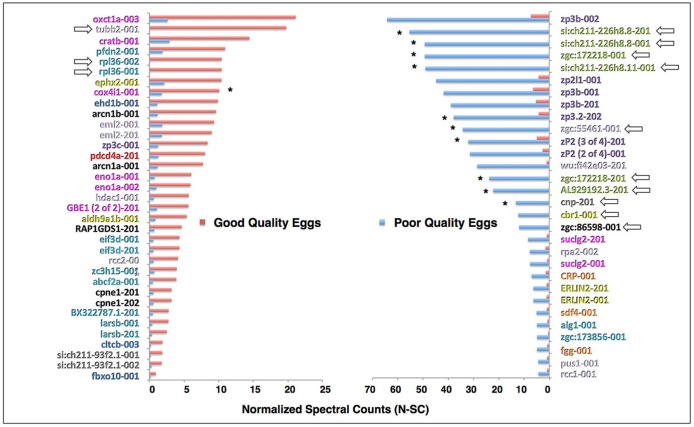
Proteins highly up-regulated in good or poor quality eggs in the Pooled Samples Experiment.The proteins are named for the transcript(s) to which spectra were mapped; for full protein names see S1 Table. These proteins were either unique to an egg quality type or they showed a ≥5-fold difference in N-SC between egg quality types, placing them in the top 2.3% of proteins showing such differences. Left Panel. Proteins highly up-regulated in good quality eggs. Right Panel. Proteins highly up-regulated in poor quality eggs. Where possible, protein (transcript) labels are color-coded to indicate functional categories to which the proteins were attributed (Fig 2). Arrows indicate proteins unique to an egg quality type. Asterisks indicate proteins detected and regulated in the same direction in the Multiple Samples Experiment.